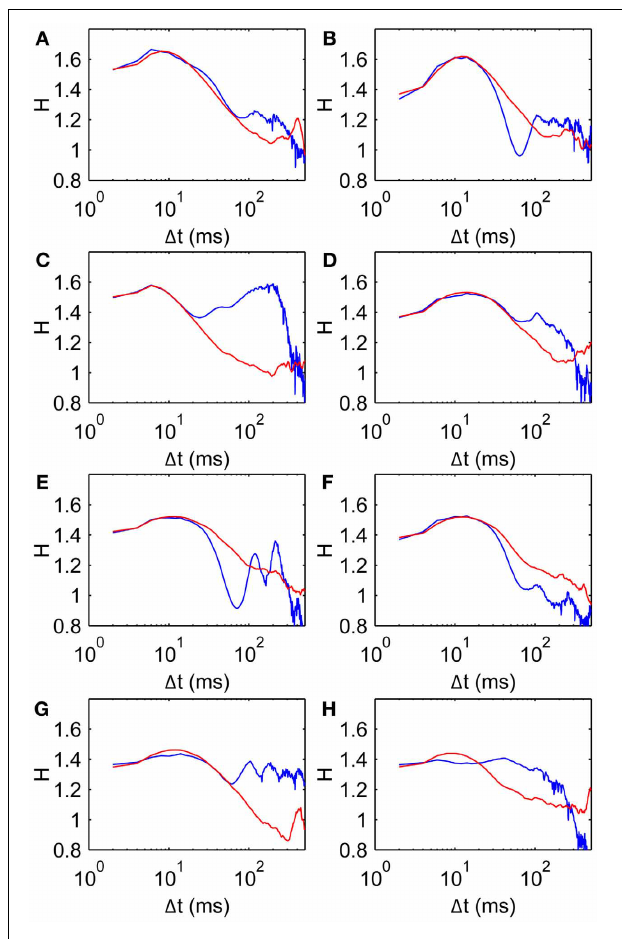
FIGURE 9 | Comparison data and model fits for all subjects. Parameters given in Table 2 . Model curves are obtained from average D 2 curves of 100 walks of 500 steps. (A–H) Subjects 1–8, respectively, showing scaling exponent H data (blue, same as Figure 3A ) and model fits (red).